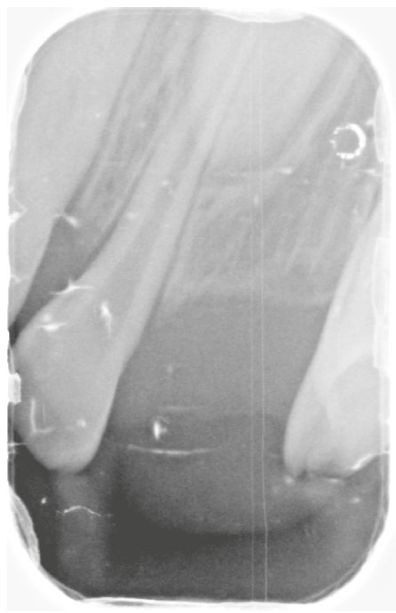
Figure 6: The periapical film confirms the absence of the primary maxillary left canine.